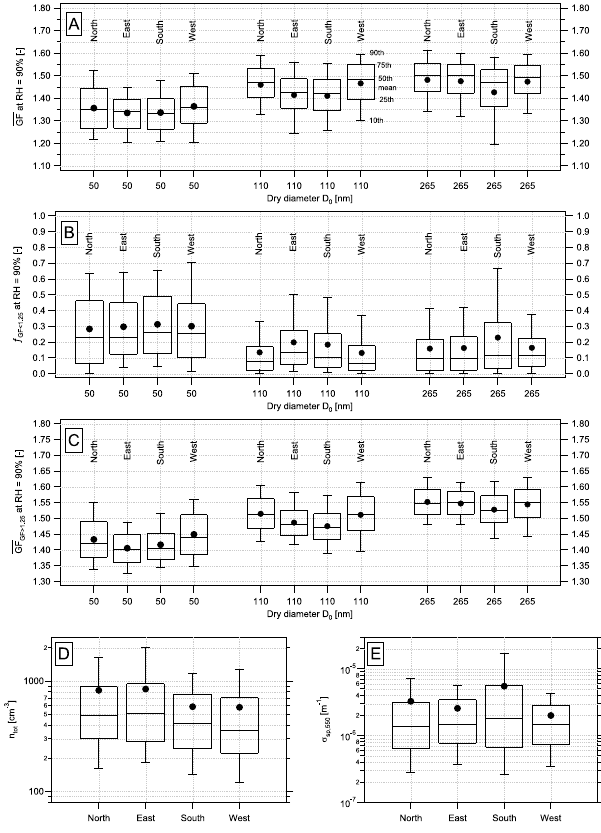
Fig. 6. Percentiles and mean values for advective weather situa- tions clustered by the synoptic scale motions north, east, south, and west at 500hPa for (A) the mean growth factor (GF) at RH=90% for D 0 =50, 110, and 265nm, (B) the number fraction of less hy- groscopic particles with GF < 1.25, f GF < 1 . 25 , (C) the mean GF of the more hygroscopic particles with GF > 1.25, GF GF > 1 . 25 , (D) the total number concentration, and (E) the scattering coefficient at the wavelength λ =550nm. Box plots with whiskers show 10th, 25th, 50th, 75th, and 90th percentiles; dots represent mean